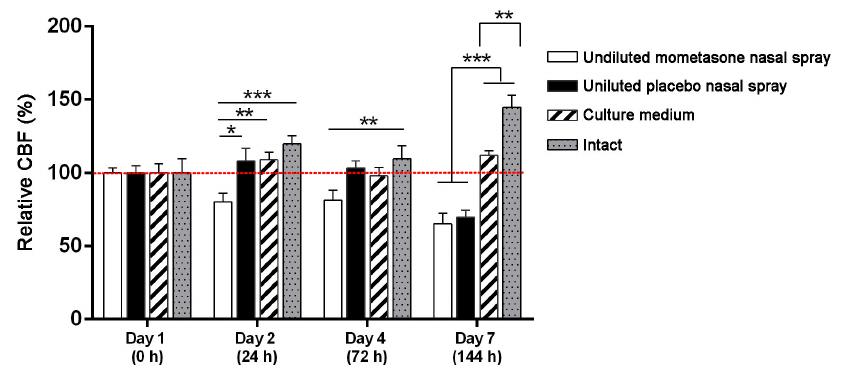
Figure 2. The effect of repeated doses of undiluted mometasone and placebo nasal spray, culture medium or intact condition on the ciliary beat frequency (CBF) of the nasal MucilAir™ in vitro model. Results are presented as relative CBF, expressed as a percentage of the CBF values relative to the corresponding baseline control condition for each tested group measured before treatments. The red dotted line represents 100% (the value of the control condition before treatment). Each bar represents the average relative CBF ± S.E. Mometasone nasal spray inhibits CBF as early as 24 h after the first treatment, and this inhibition persist on days 4 and 7. Placebo nasal spray significantly inhibits CBF on day 7 of continuous treatment. n = 25; two-way ANOVA with Tukey’s multiple comparisons test; * p < 0.05, ** p < 0.01, *** p < 0.0001. Pharmaceutics 2021 , 13 , 1750